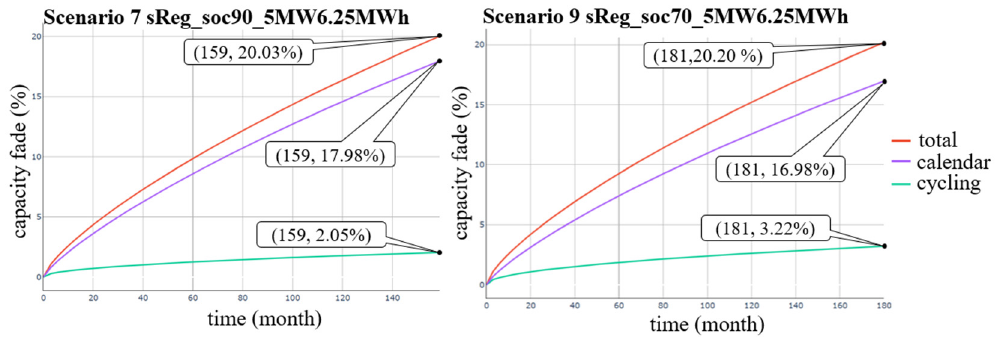
Figure 21. The aging ratio of Scenarios 7 and 9. Table 4. Battery life overview for each scenario.